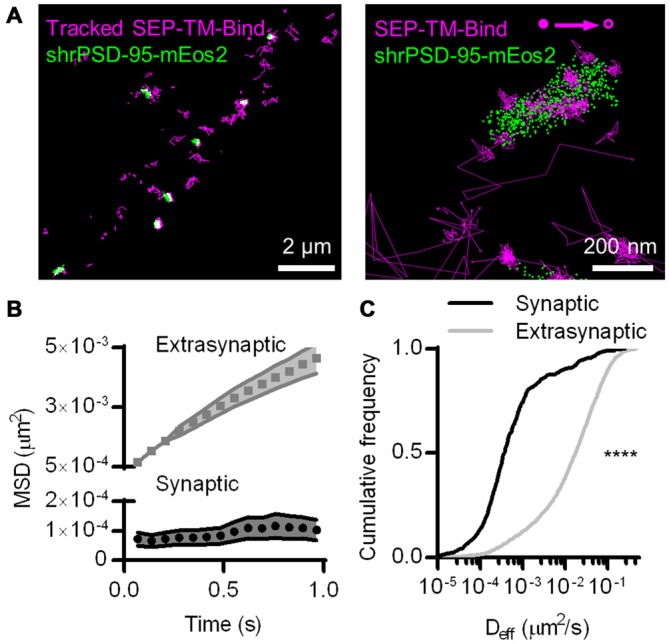
Photoactivated localization microscopy (PALM)-point accumulation-for-imaging-in-nanoscale-topography (PAINT), single-molecule tracking during PALM imaging. (A) (Left) Super ecliptic phluorin (SEP)-TM-Bind molecules tracked for at least eight frames super-imposed on molecules of shrPSD-95, accumulated from 5000–20,000 frames. (Right) A typical example of tracked probes superimposed on positions of shrPSD-95 molecules. The first and last localized positions are indicated as filled and open circles, respectively. (B) Mean squared displacement (MSD) over time of connected sub-segments of tracks (subtracks) that are lasted at least 15 frames (n = 156 synaptic and 2907 extrasynaptic tracks/113 PSDs/13 fields/11 cells/3 cultures). (C) Cumulative frequency distributions of Deff for subtracks that are at least eight frames long (n = 654 synaptic and 3349 extrasynaptic tracks/113/13/11/3). ****p < 0.0001.